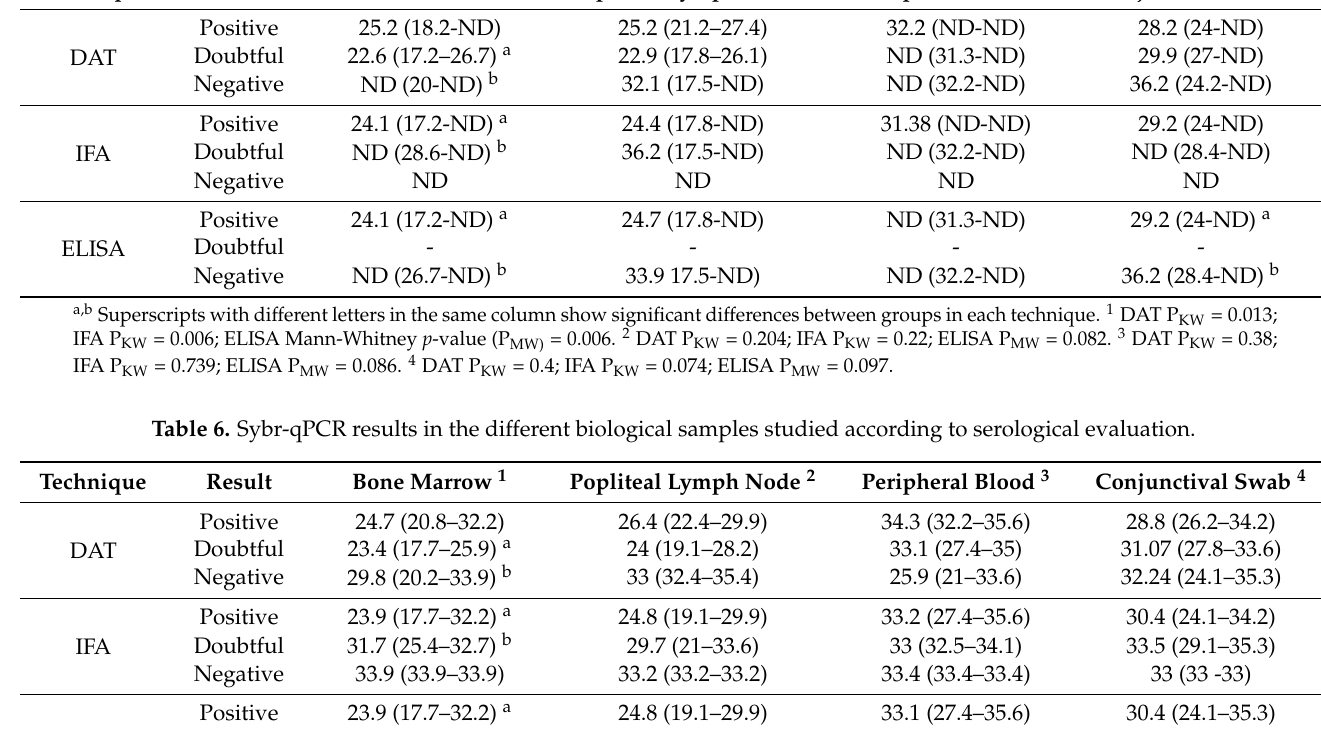
Table 5. TaqMan-qPCR results in the different biological samples studied according to serological evaluation. Technique